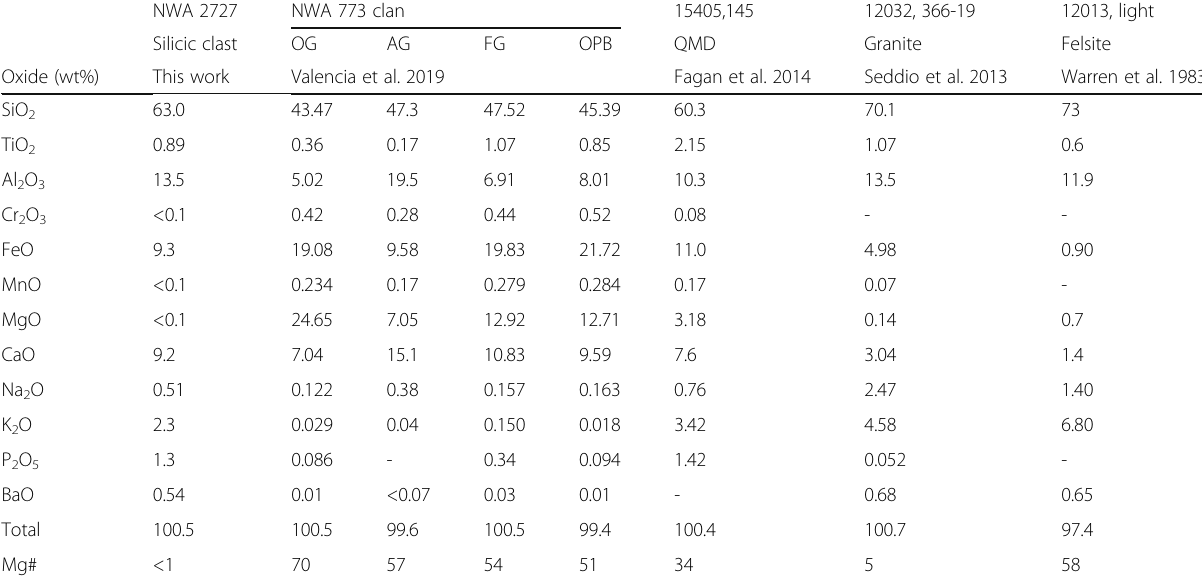
Table 4 Major element abundances of the silicic clast (this work), other lithologies (OG, AG, FG, OPB) in NWA 773 clan, and Apollo evolved